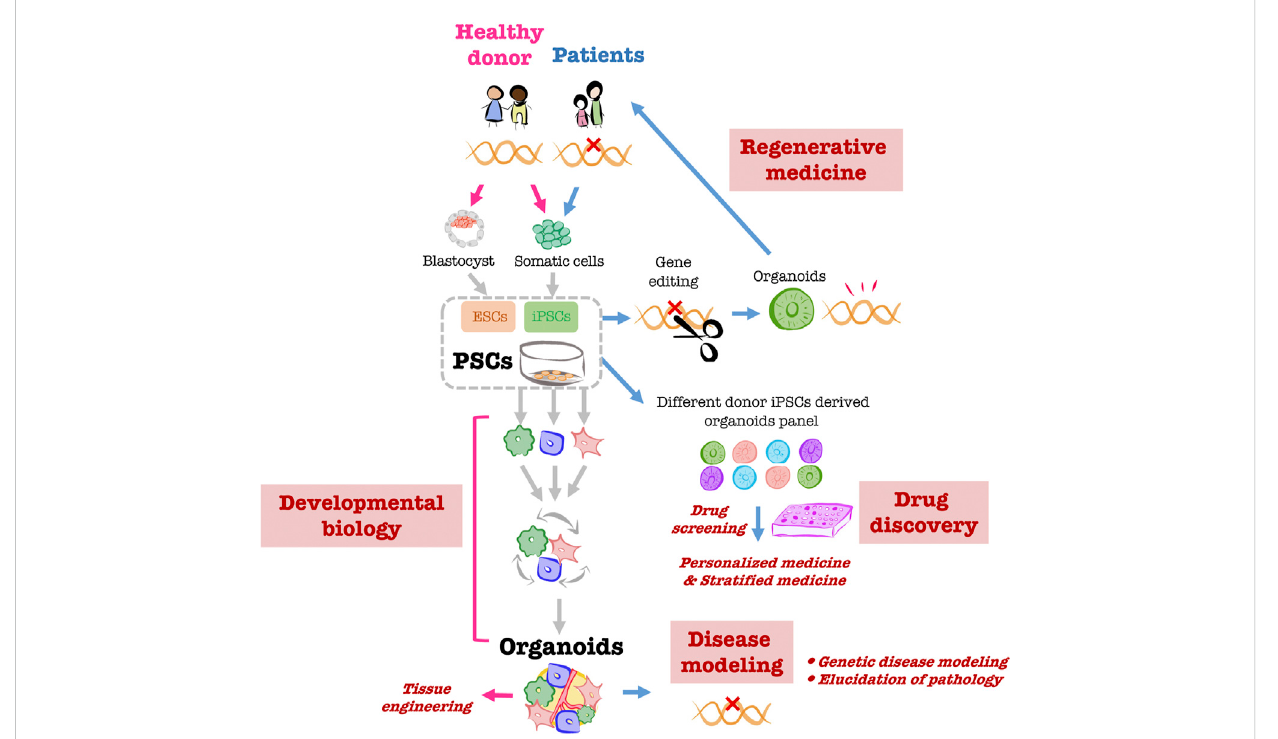
FIGURE 1 Overview of PSC-derived liver organoid applications Creating organoids using PSCs obtained from healthy donors enables the in vitro reproduction of humanorganogenesisthroughwhichmultiplecellscoexistandbuildupduringdevelopment.Theorganoidscreatedthroughthisprocesscanbeusedashelpful exvivo modelsfortissueengineering.Organoidscreatedfrompatient-derivediPSCswillbeutilizedforpathologicalmodeling.Itisanticipatedthatorganoidpanels created from multiple human iPSCs will be used as platforms for drug screening and other applications and will be applied to personalized and strati fi ed medicine. Moreover, gene editing of patient-derived iPSCs will enable the creation of organoids for transplantation into the same patient.